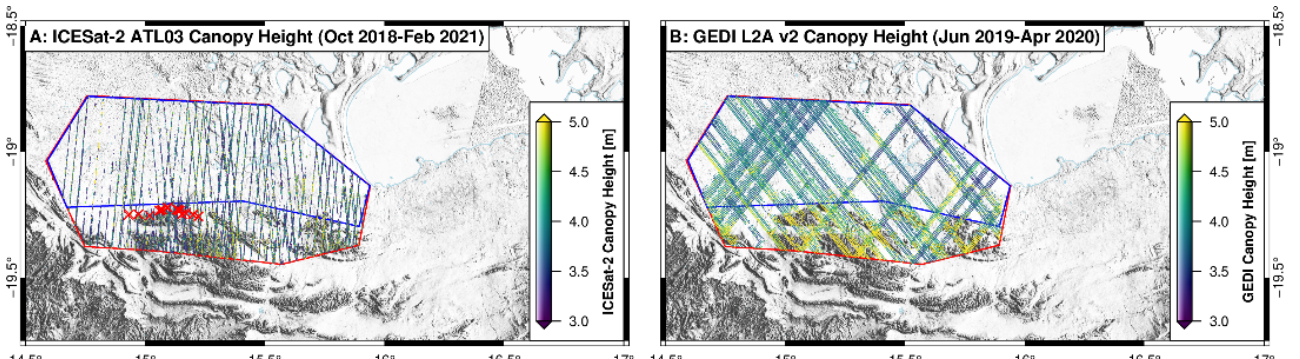
Figure 1. Geographic overview of the study area ( A ). International borders are indicated by black lines, lakes and wetlands are shown in light blue colors, and major rivers are in blue color. ( B ): Mean NDVI derived from Landsat 8 (2014–2021) for the study area including savanna and mountainous terrain (red polygon) and an area confined to the savanna ecosystem (blue polygon) [31]. Major roads are shown by black lines. ( C ): Range of the NDVI values between the 10th and 90th percentile showing the variability of vegetation cover. Higher values indicate higher seasonal vegetation changes.